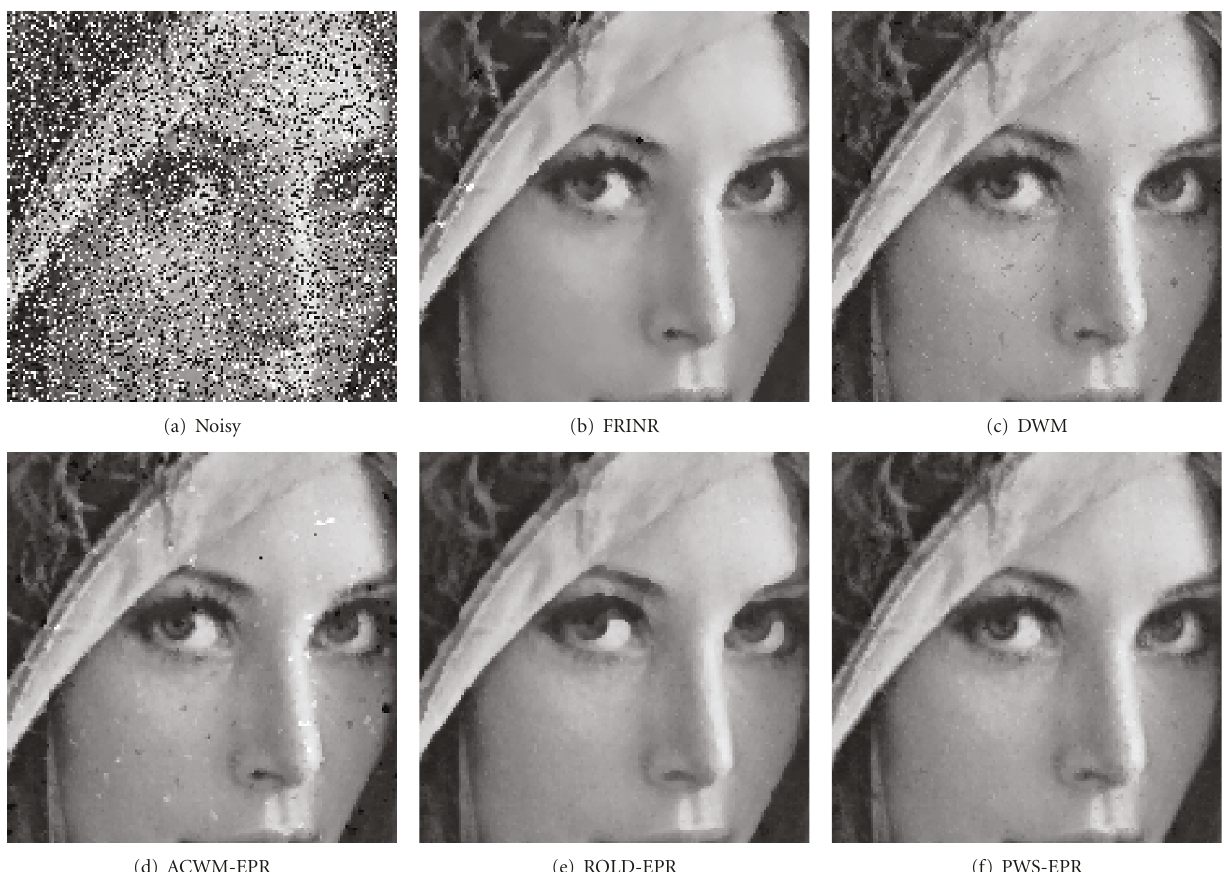
Figure 7: Details from the Lena test image corrupted with 40% of mixed impulse noise, and results obtained by applying di ff erent filters. where N is the set of all pixels marked as noisy in the noise map, V ij is the set of the four closest neighbors of ( i , j ), and ϕ () is the edge-preserving potential function